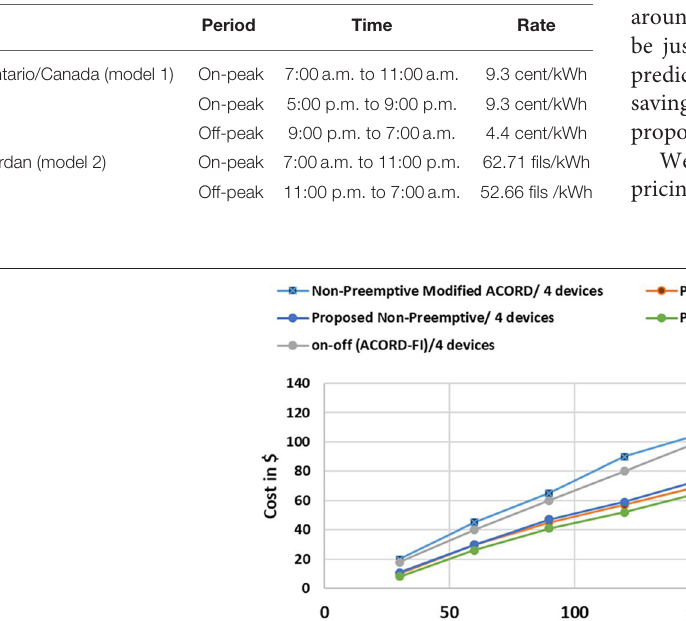
TABLE 5 | TOU rates (Erol-Kantarci and Mouftah, 2010a,b, 2011).